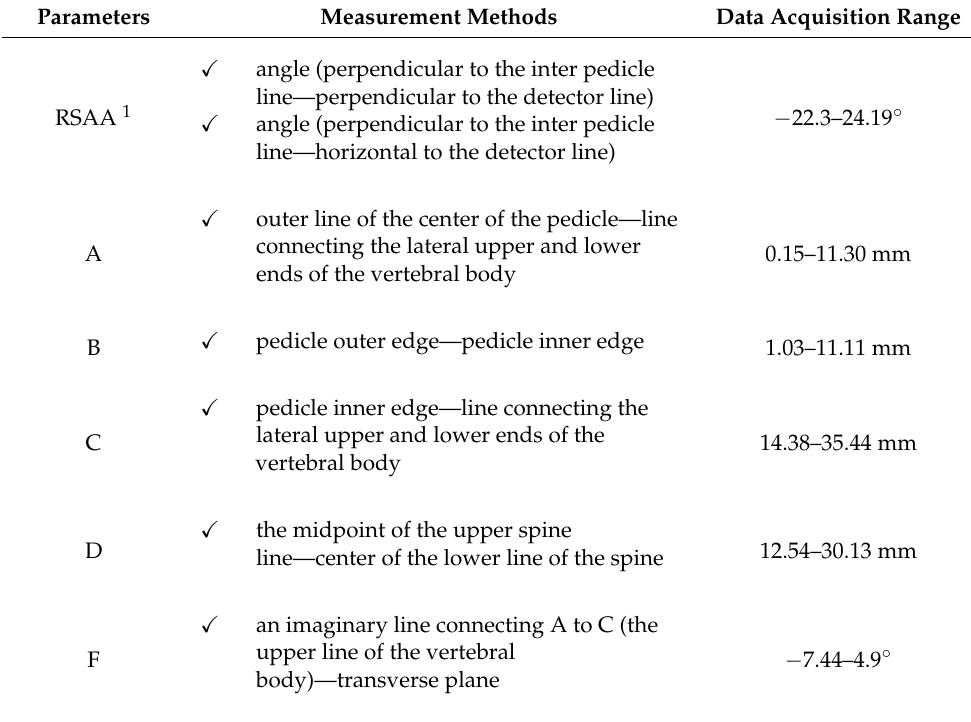
Table 1. Results of parameter setting/measurement method and data acquisition